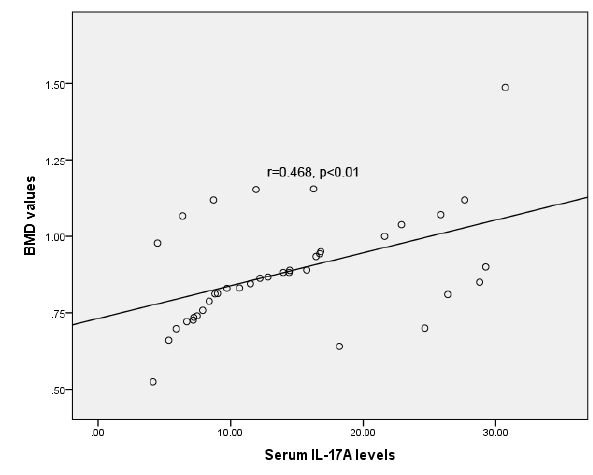
Figure 2. Correlation between serum IL-17A levels and BMD